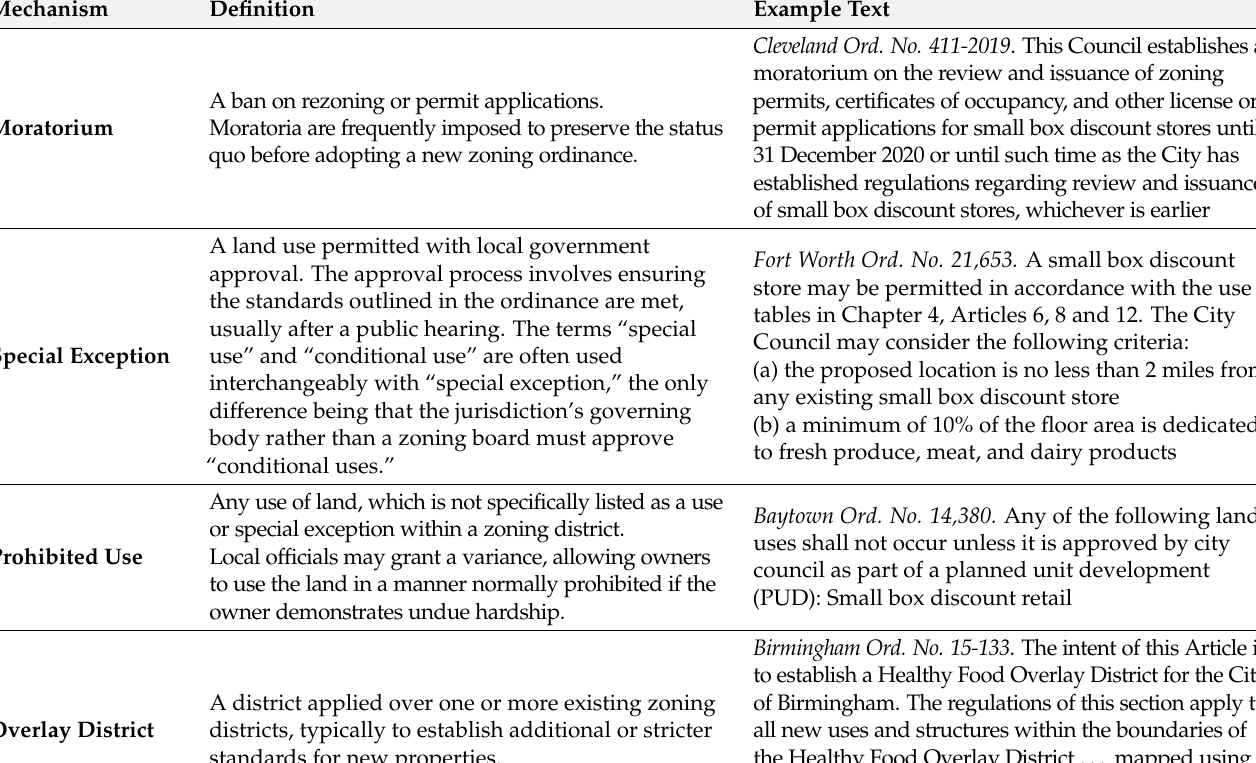
Table 1. Definitions of legal mechanisms and examples of key legal